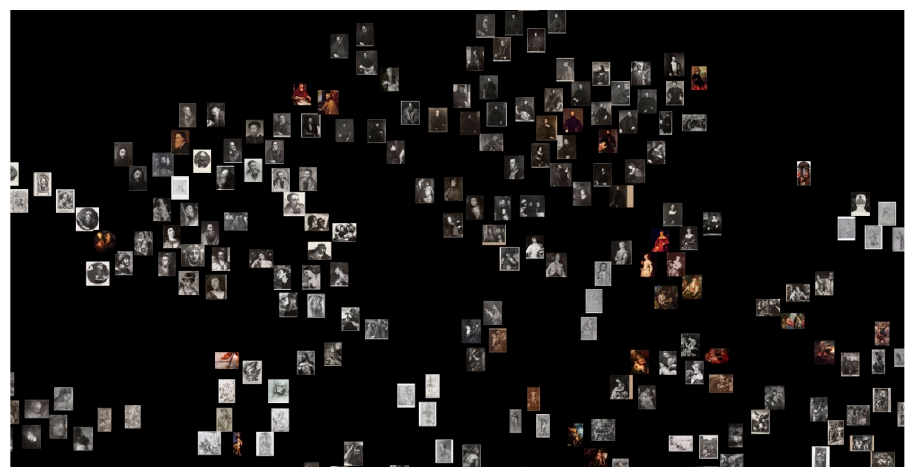
Figure 11. Morphograph of Titian’s artworks in the Fondazione Giorgio Cini dataset .